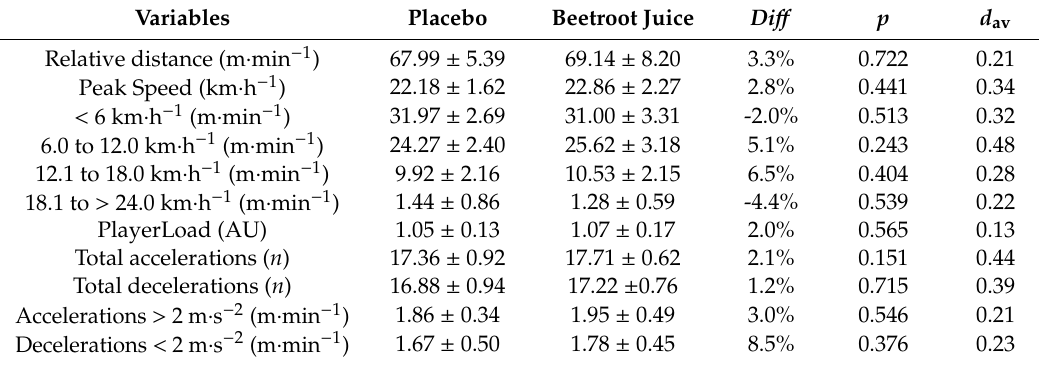
Table 1. External load values (means ± SD) obtained in placebo and beetroot conditions during basketball match-play